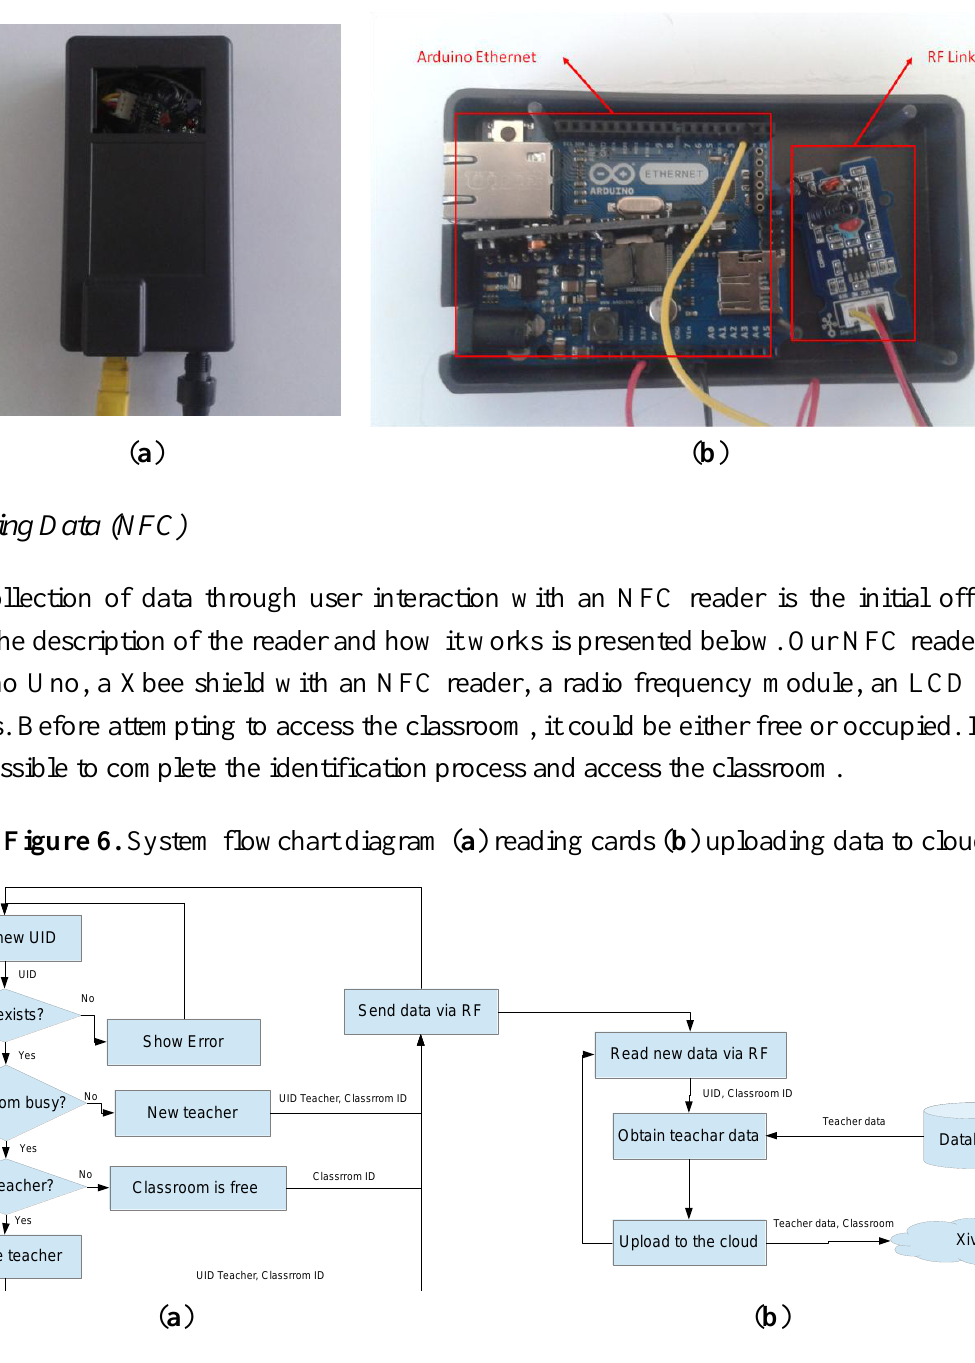
Figure 5. Master node hardware prototype: ( a ) outside ( b ) inside.